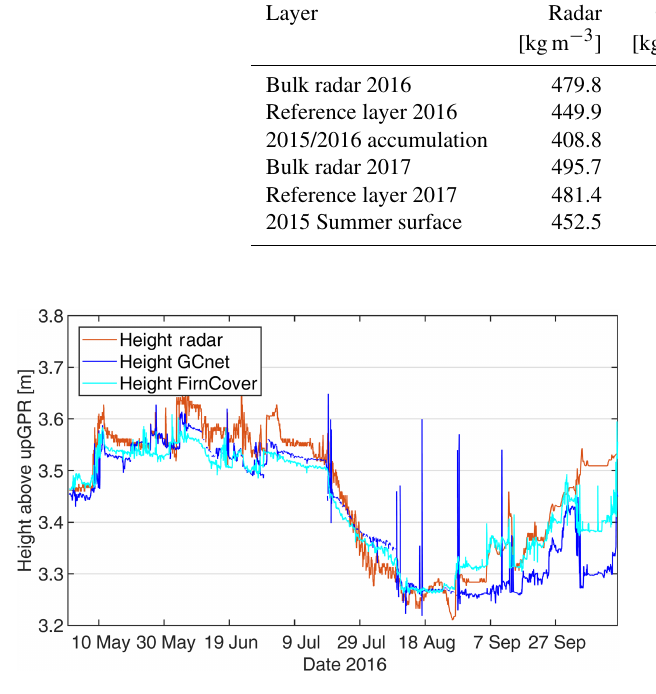
Figure 4. Comparison of derived thickness from radar of the snow and firn column above the antennas with changes in snow depth recorded by two different ultrasonic